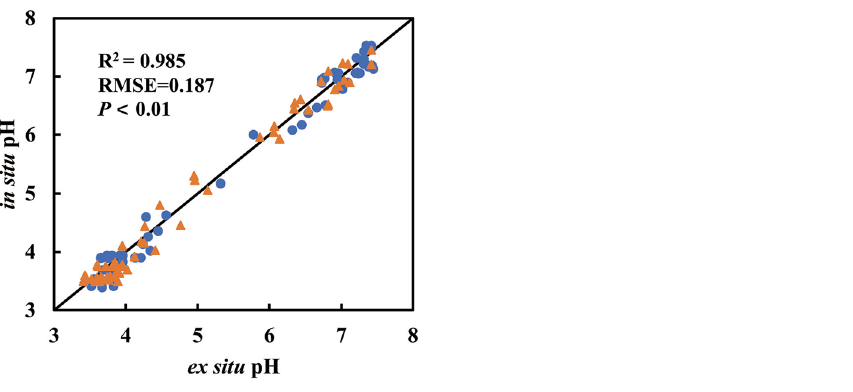
Figure 3. Comparison of in situ data from the 12 instrumented jars and ex situ data from the additional 120 jars. The solid line is the line of equality.